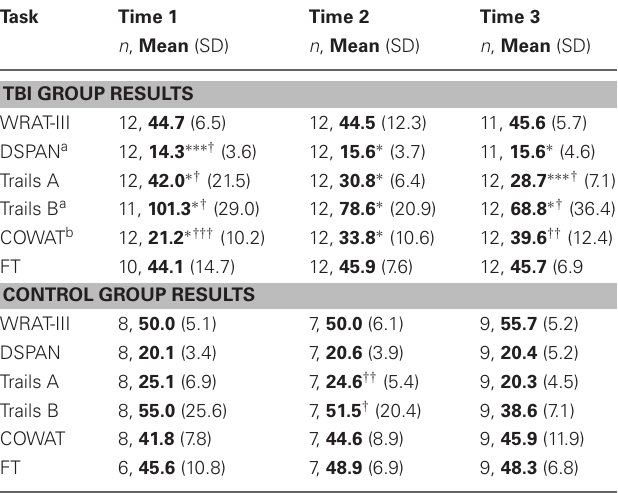
Table 2 | Neuropsychological test